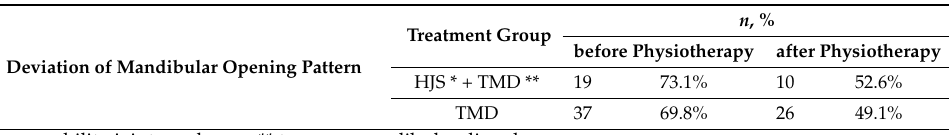
Table 4. Changes in the deviation of mandibular opening pattern before and after physiotherapy ( n = 52).